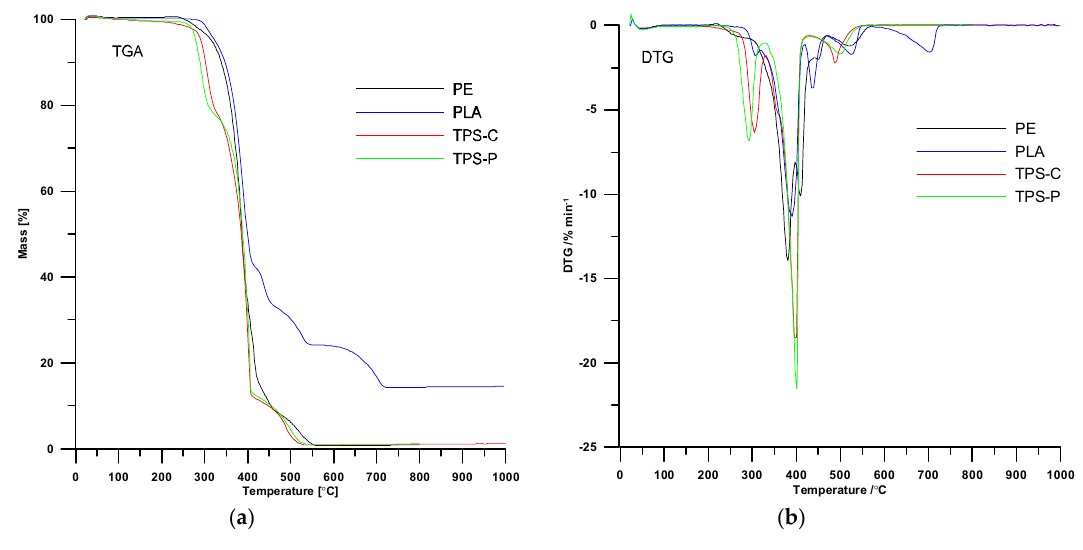
Figure 2. TGA ( a ) and DTG ( b )curves of tested granulates. Table 5. Results obtained based on TGA curves for